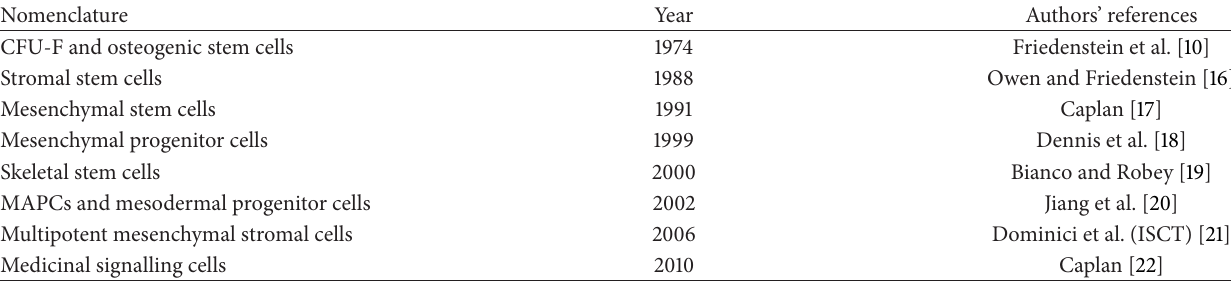
Table 1: Summary of mesenchymal stroma cell